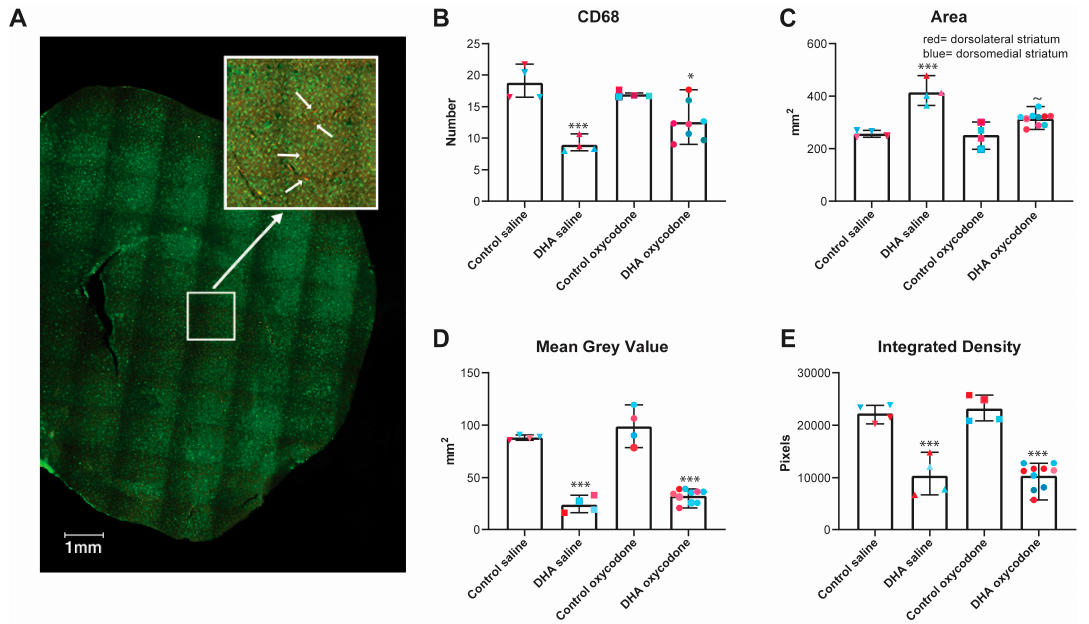
Figure 5. The activation state of microglia was a ff ected by the n-3 PUFA-enriched diet but not by the oxycodone self-administration. To assess the activation state of microglia, the number of CD68-labeled cells in the dorsomedial and dorsolateral striatum were counted and the shape and density of IBA1 labeling in these CD68 + cells was assessed. There was no e ff ect of region on any of these parameters, so the dorsomedial and dorsolateral data were combined. ( A ) A representative example of a coronal section with CD68 labeled in red and IBA1 in green. An example of the dorsolateral region was enlarged, with the arrows showing cells that were labeled with both the CD68 and IBA1 antibodies. ( B ) CD68. The n-3 PUFA dietary regimen reduced the number of CD68 + cells compared to the control group (*** p < 0.001) but opioid IVSA did not induce any further change (* p < 0.05, n-3 PUFA oxycodone vs. control oxycodone). ( C ) Cell area. The area of the cells of the controls, whether saline or opioid-treated, was lower than that of the n-3 PUFA control (*** p < 0.001) or opioid-treated (* p < 0.05) groups. The n-3 PUFA opioid-treated group did show a decrease in cell area compared with the n-3 control diet group ( p ≈ 0.05). ( D ) Mean grey value or average pixel density. This parameter showed an e ff ect of treatment with the n-3 PUFA groups, whether saline or opioid-treated, showing a lower pixel density than the control groups (*** p < 0.001 in both groups). ( E ) Integrated density or the sum of the pixels in the selected area. This parameter was similarly altered by treatment with an e ff ect from n-3 PUFA (*** p < 0.001), but no e ff ect from opioid